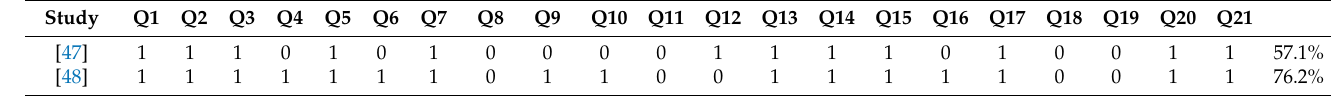
Table 2. Assessment of qualitative studies